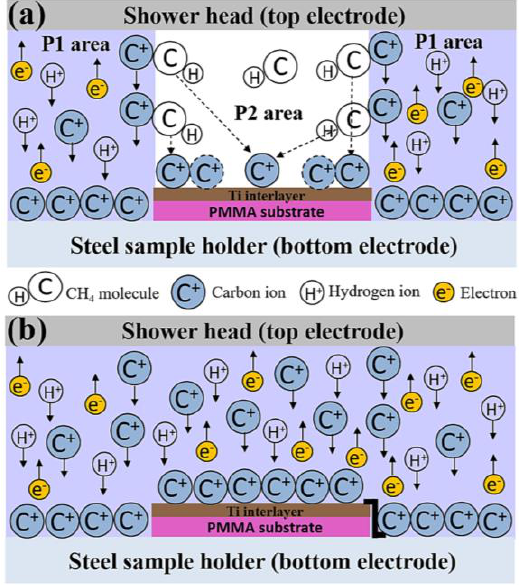
Figure 4. Schematic diagram of deposition mechanism of films deposited on Ti/PMMA with ( b ) and without ( a ) conductive material.